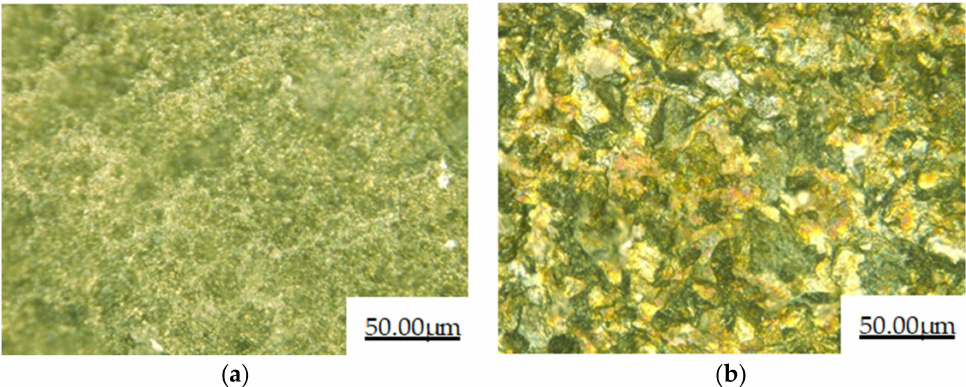
Figure 10. Immersion corrosion morphology of the ( a ) cladding layer and ( b ) 27SiMn